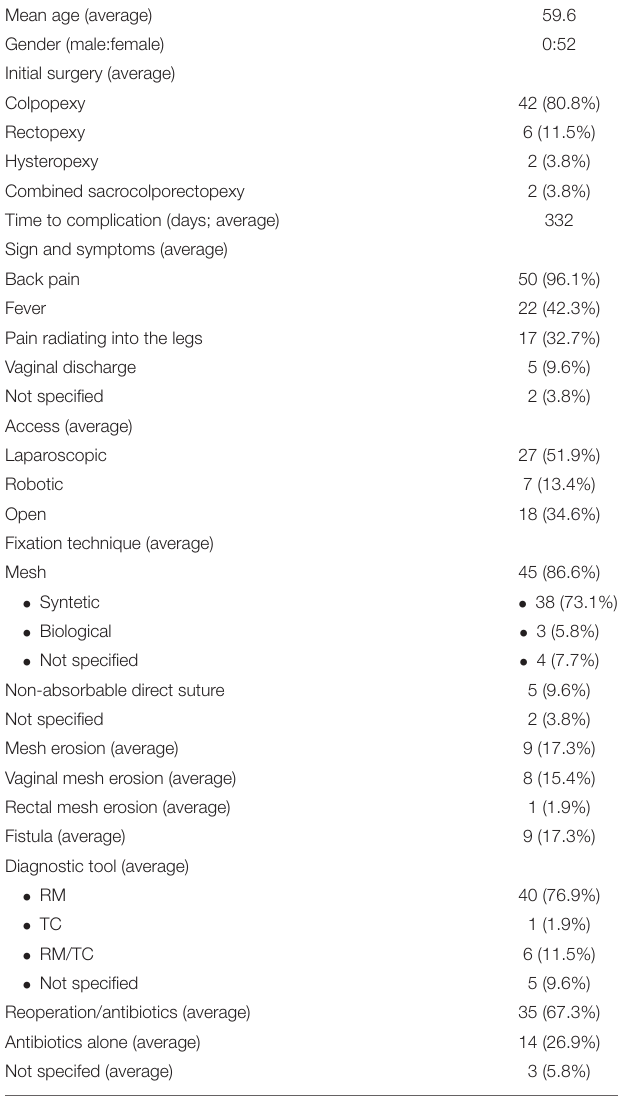
TABLE 4 | Baseline characteristics, presenting symptoms and type of treatment ( n =